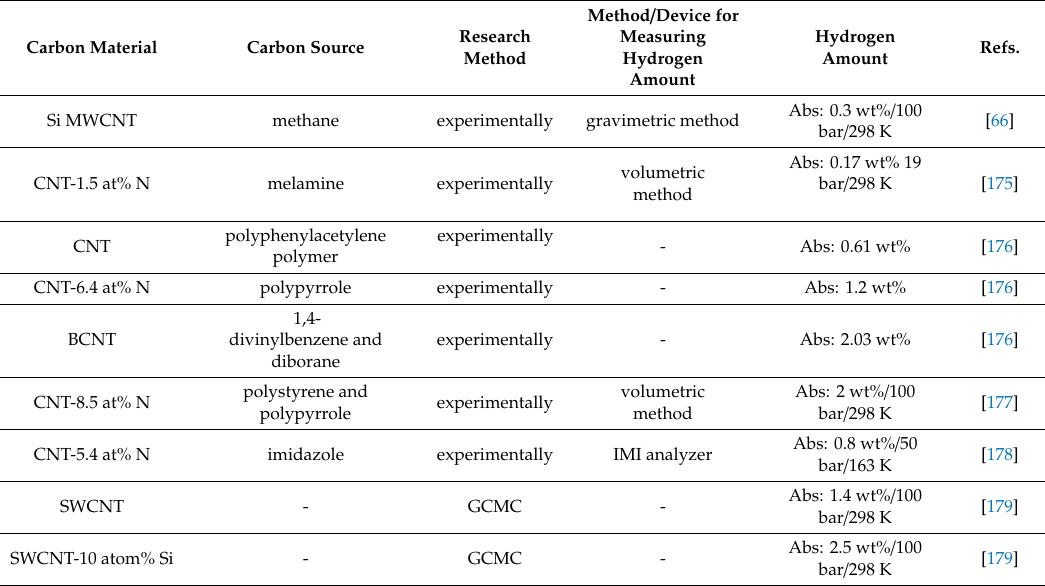
Table 3. Hydrogen storage properties of CNTs modified by